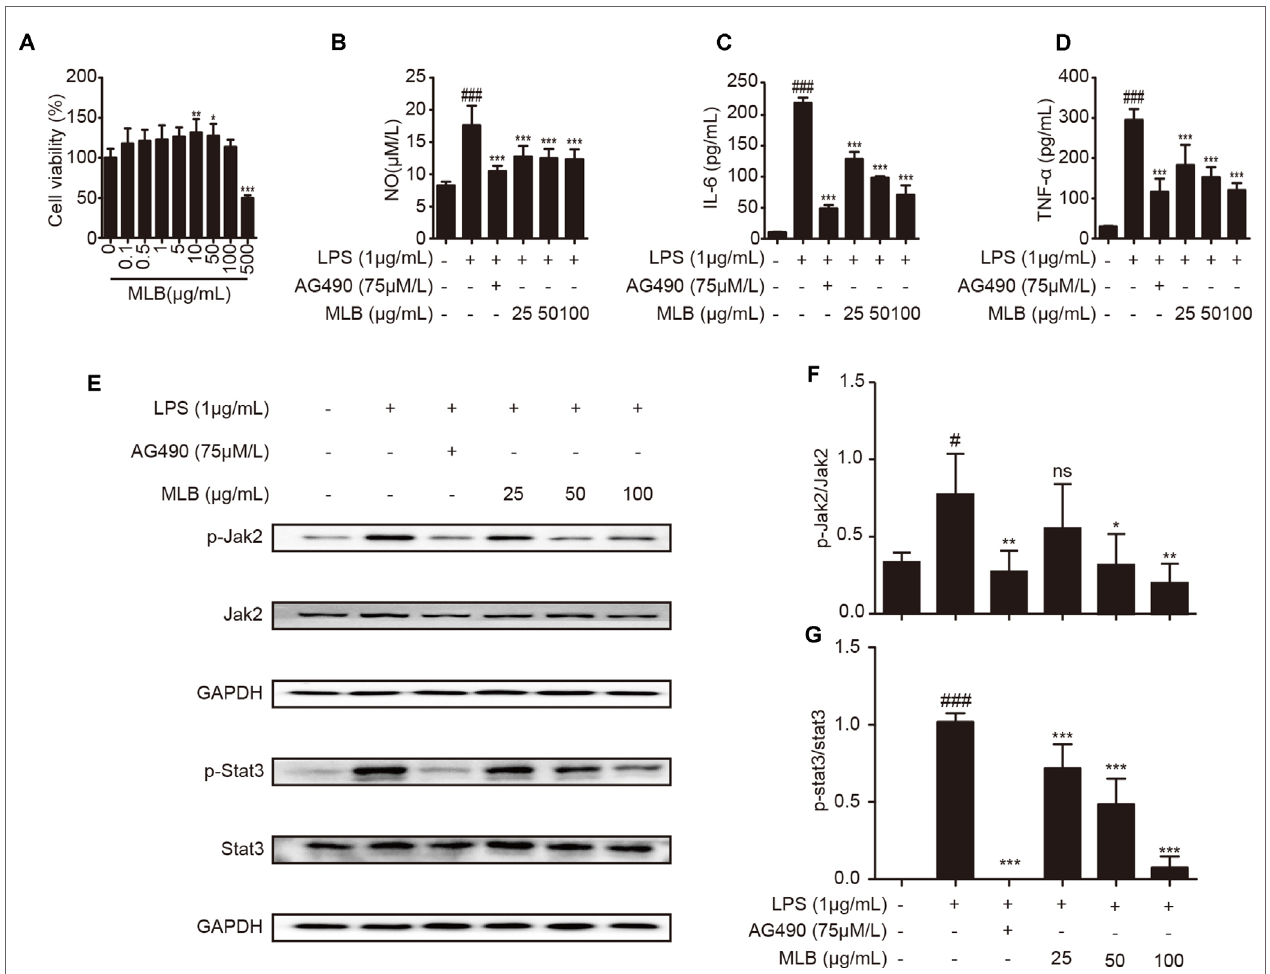
FIGURE 8 | MLB inhibited inflammation via Jak2/Stat3 in RAW264.7. (A) Cell viability was examined using CCK-8. (B) The NO production was measured by Griess assays in cell media, and the levels of IL-6 (C) and TNF- α (D) were ascertained by ELISA. (E – G) The levels of the Jak2/Stat3 signaling pathway were measured by Western blotting. All samples were from 5 independent experiments. Each value is expressed as mean ± SD; n = 5 for each group; ns: no statistical significance; # P < 0.05, and ### P < 0.001 versus NC group; *P < 0.05, **P < 0.01, and ***P < 0.001 versus LPS